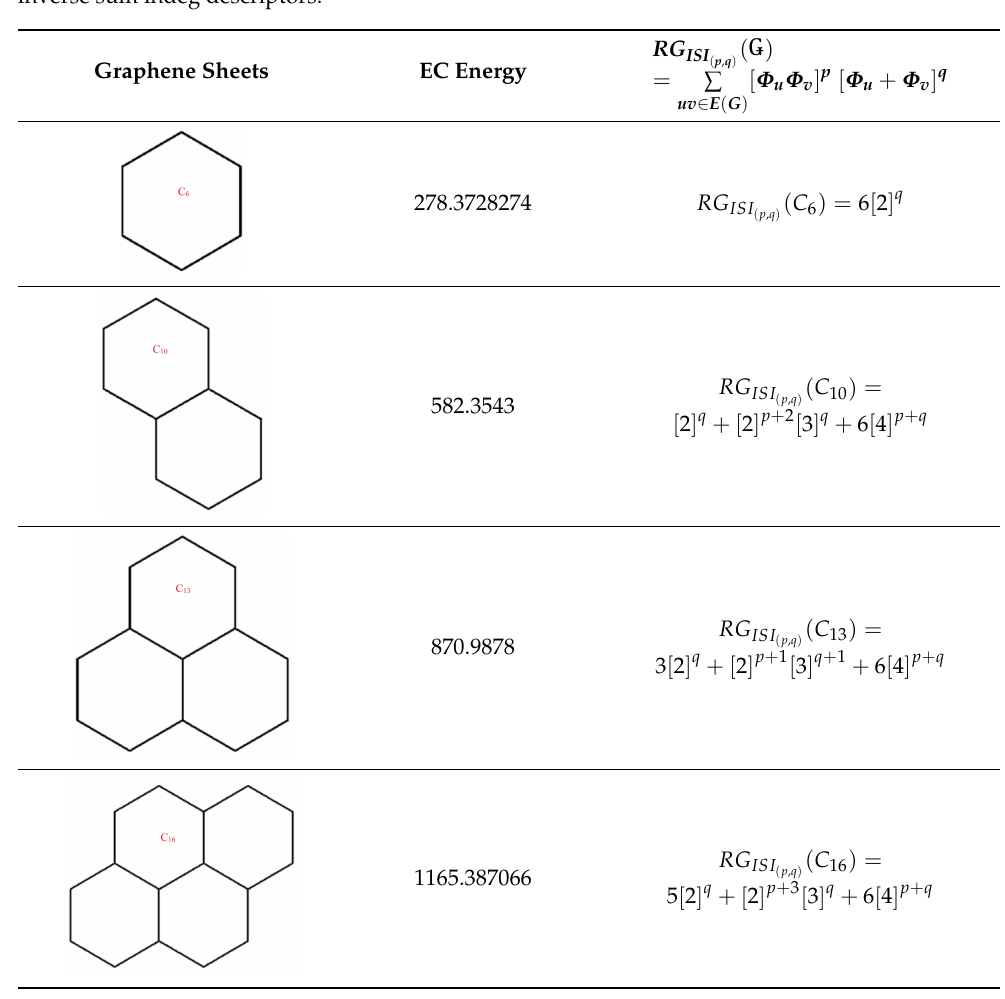
Table 2. Graphene sheets from C 6 to C 32 with their exchange-correlation energy and reverse general inverse sum indeg descriptors.